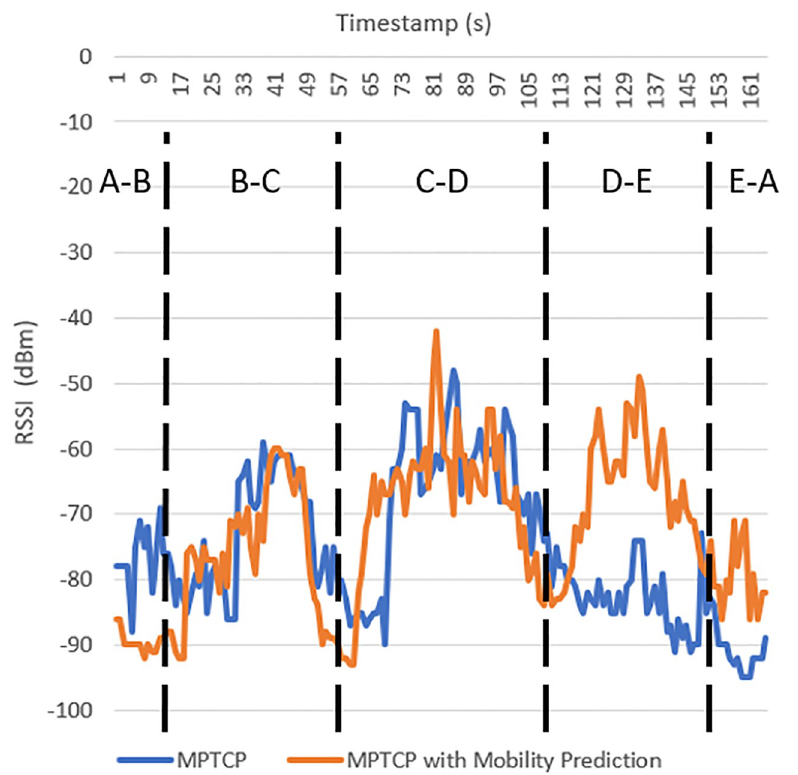
Fig 27. RSSI of connected WiFi AP in MPTCP and MPTCP with mobility